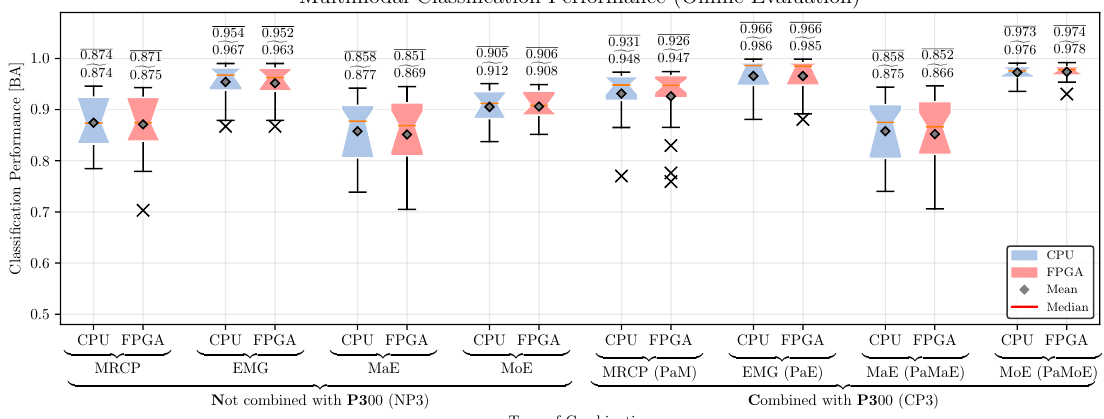
Figure 12. Classification Performance for Hybrid Movement